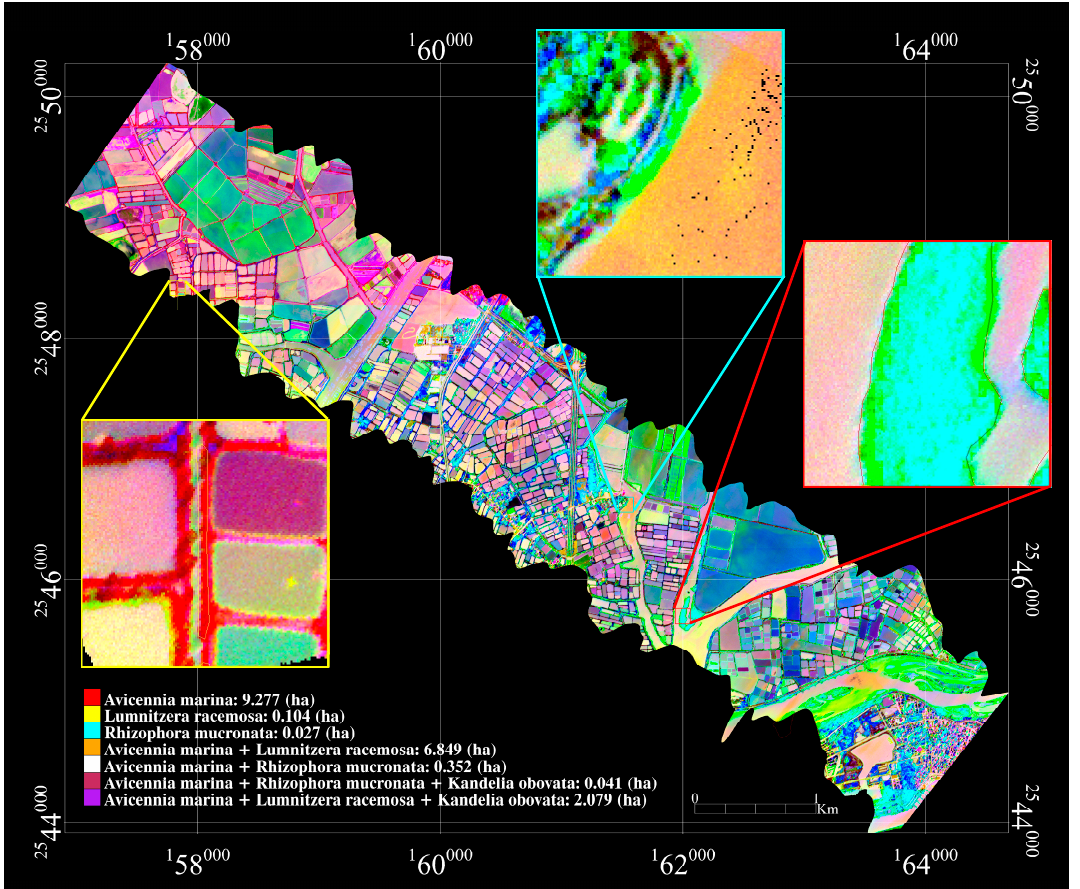
Figure 12. The false-color composite of the MNF-transformed image by designating the MNF bands 2, 7, 10 as the red, green and blue channels. Three endmembers are collected at the center pixels of three training areas with pure mangroves, including Avicennia marina (red box), Lumnitzera racemosa (yellow box) and Rhizophora mucronata (cyan box), as plotted and compared in Figure 11.